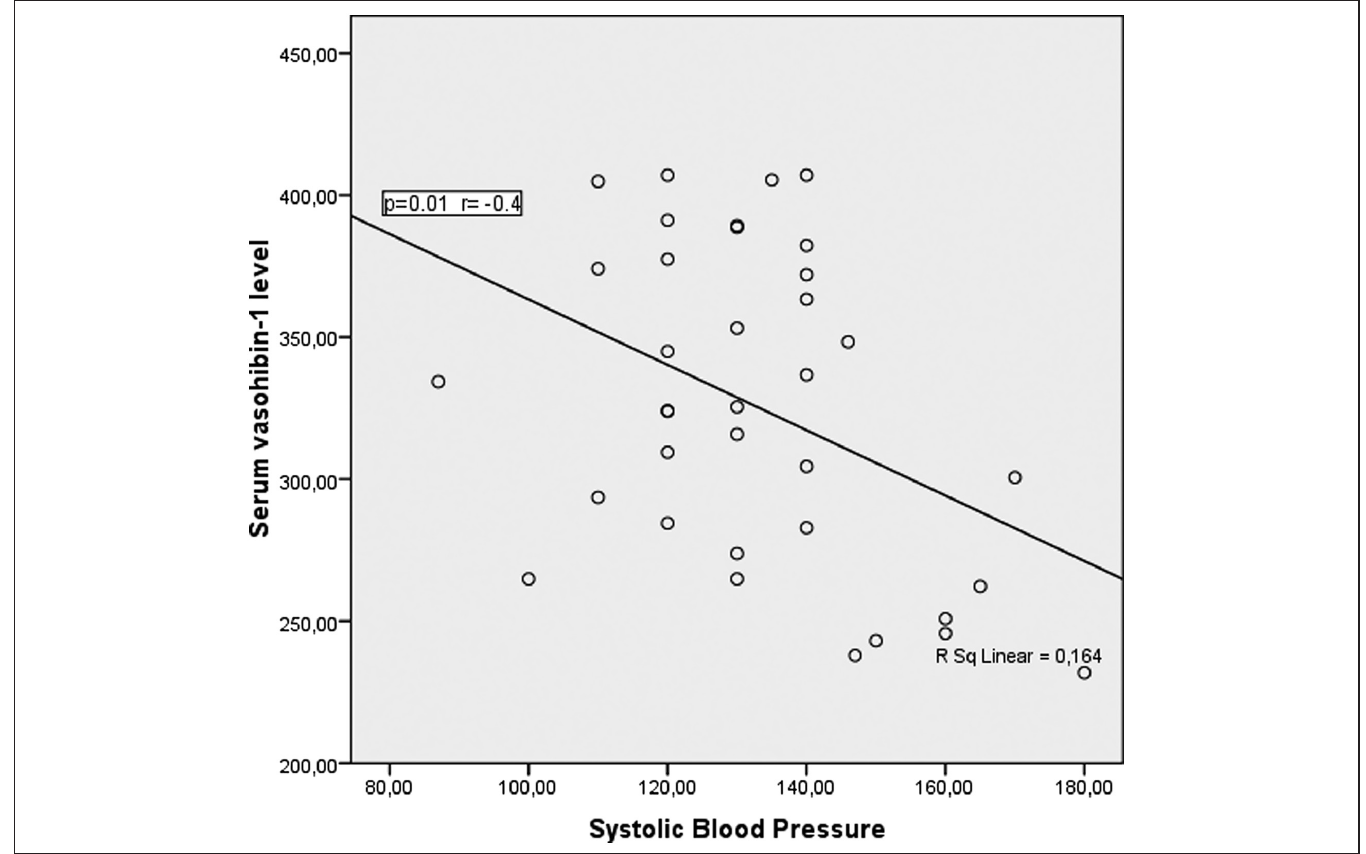
Figure 2. Correlation graphic between SBP and serum vasohibin-1 level of patients with DKD. DKD, diabetic kidney disease; SBP, systolic blood pressure.